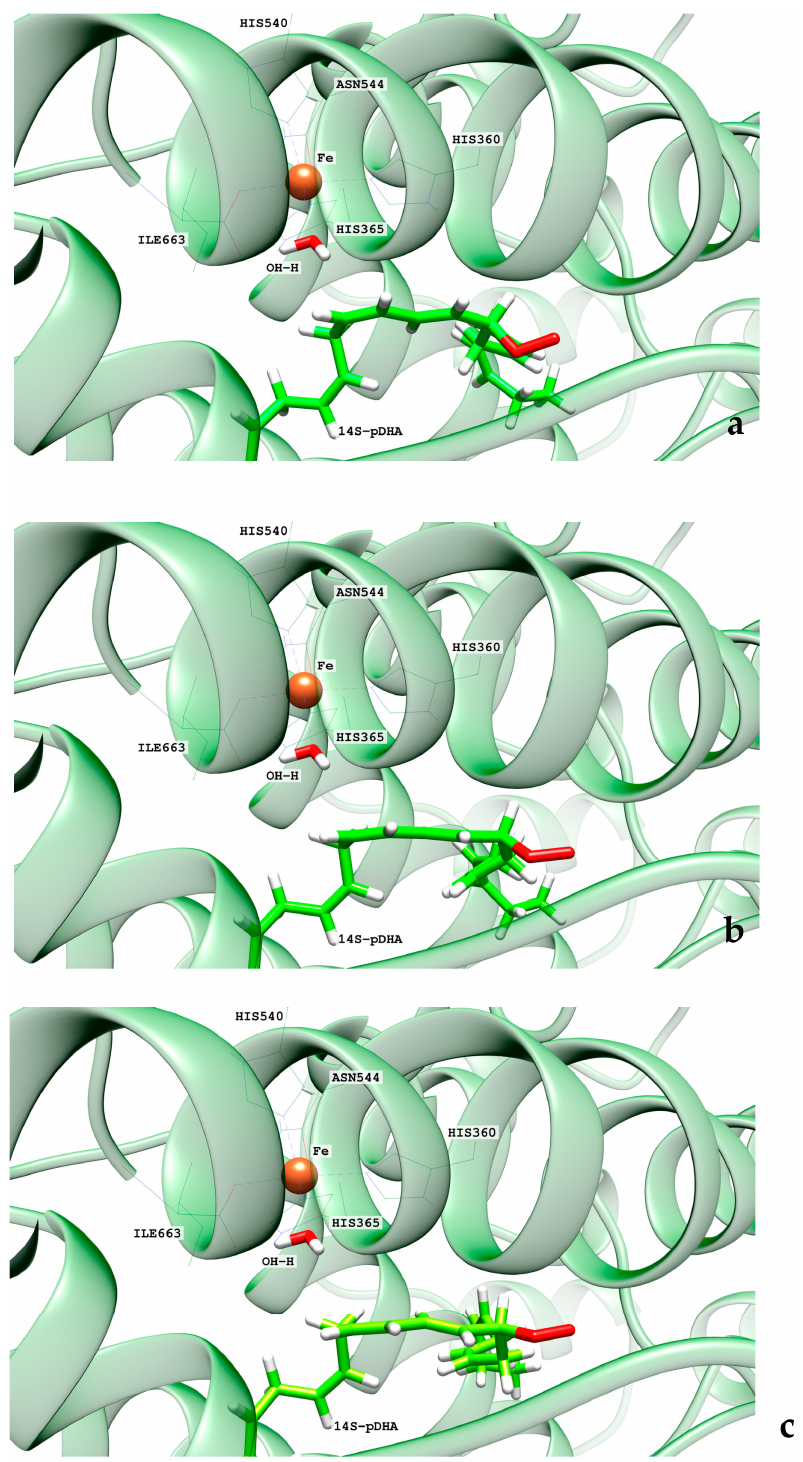
Figure 14. Images of the optimized reactant ( a ), transition state structure ( b ), and product ( c ) of the carbon chain rotation of the peroxyl radical (frame 8721) in hALOX12.